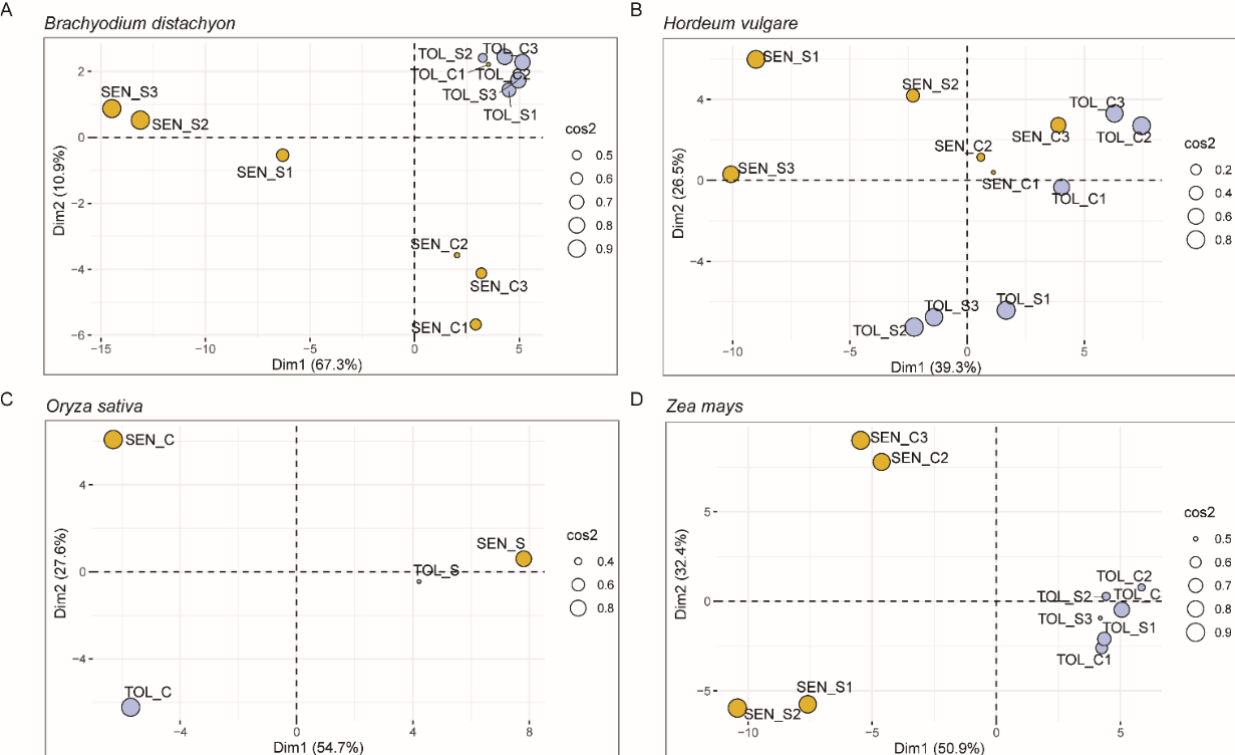
Figure 2. Principal component analysis (PCA) biplots of the four RNA-Seq datasets using the TPM expression values of the CDT genes of B. distachyon ( A ), H. vulgare ( B ), O. sativa ( C ), and Z. mays ( D ). Samples from the sensitive genotypes are in yellow, whereas those from the tolerant genotypes are in light blue. Squared cosine (cos2) indicates the contribution of each sample to a given observation; the bigger the circle is, the higher the contribution is. TOL_C: biological replicates of the toler- ant genotypes that were used as non-stressed control in the experiments; TOL_S: biological replicates of the tolerant genotypes under drought stress; SEN_C: biological replicates of the sensitive genotypes that were used as non-stressed controls; SEN_S: biological replicates of the sensitive genotypes under drought stress.